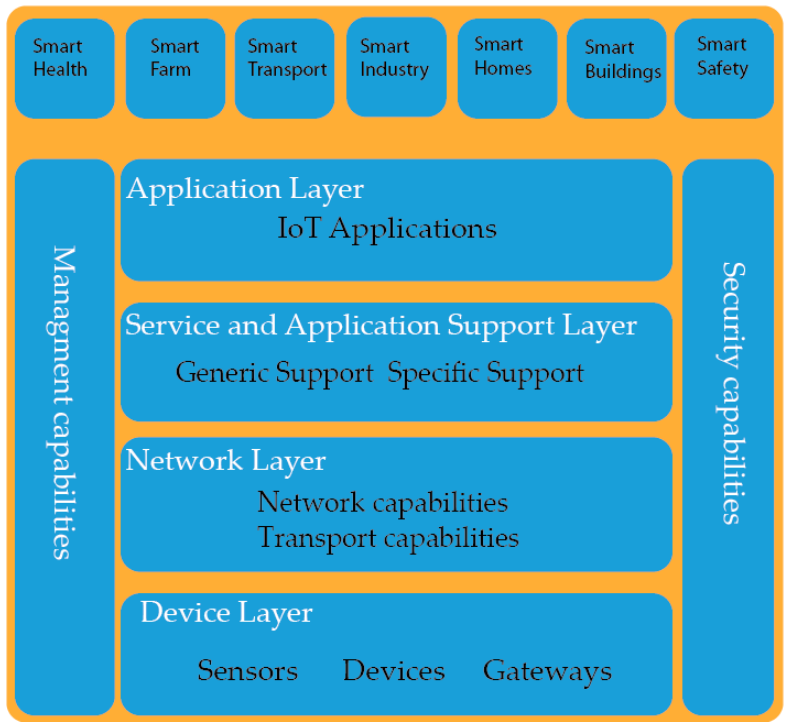
Figure 5. IoT generic model proposed by the International Union of Telecommunications (ITU) in recommendation Y.2060 [20].